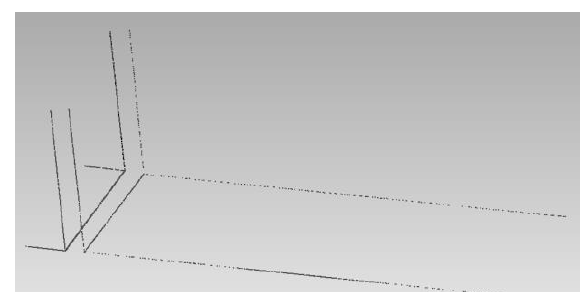
Figure 14. The extracted edges from the point cloud of the interior of the Temple